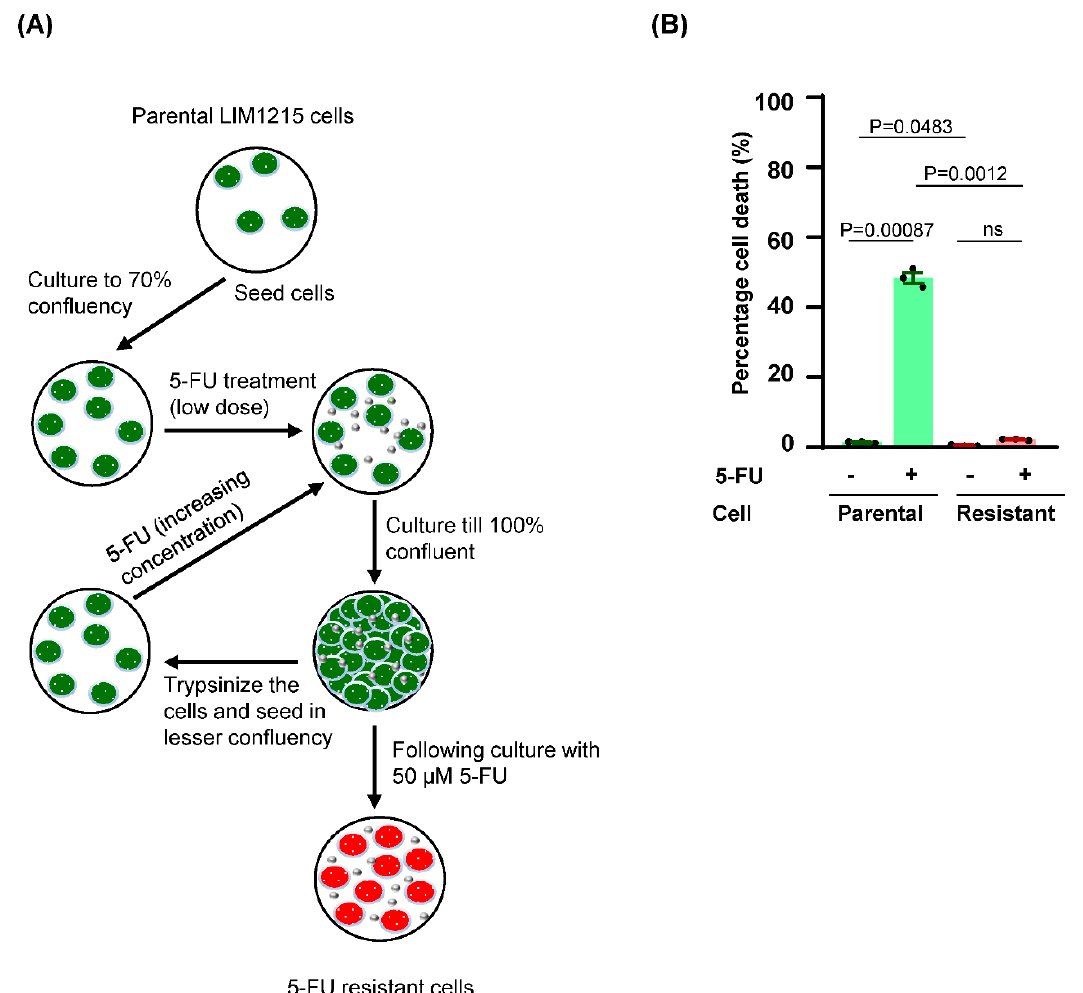
Figure 1. Colorectal cancer (CRC) cells gain resistance to 5-fluorouracil (5-FU) with long term exposure to 5-FU. ( A ) For developing 5-FU resistance in LIM1215 cells, parental cells were cultured continuously until they got fully confluent with increasing concentrations of 5-FU (1, 5, 10, 25 to 50 µ m). ( B ) FACS apoptosis assay performed with LIM1215 parental and resistant cells following treatment with 50 µ m 5-FU for 72 h showed that resistant cells are protected from 5-FU mediated cell death. ns; not significant. Data is presented as mean ± s.e.m.; significance determined by Student’s t-test (n = 3).